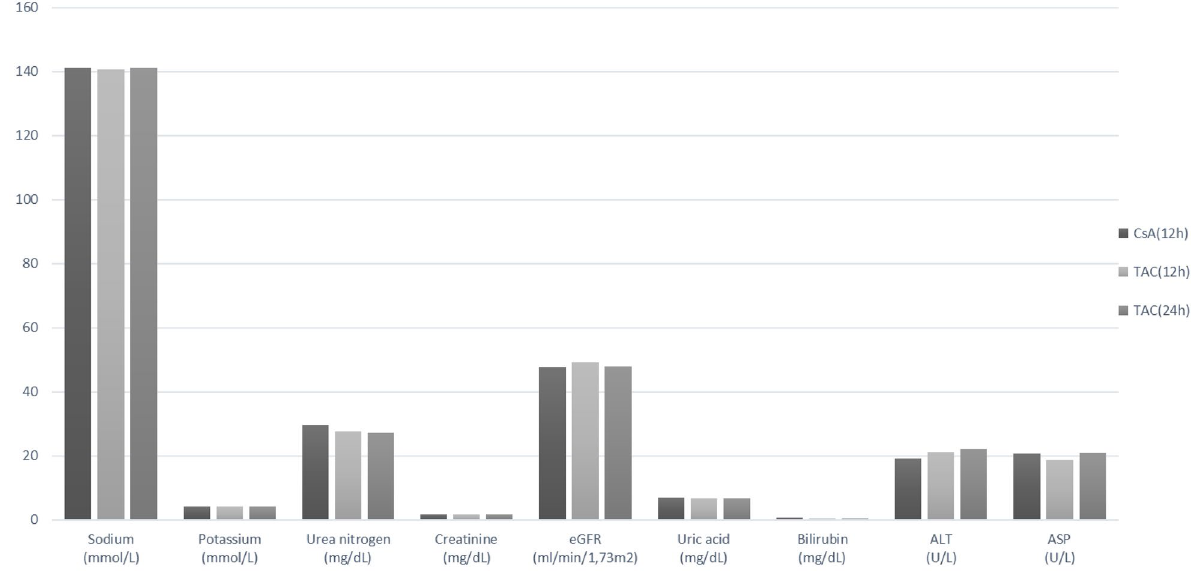
Figure 1. Characteristics of selected clinical and biochemical parameters in renal transplant patients receiving cyclosporine A (CsA) or tacrolimus (TAC) every 12 or 24 h. (CsA-12 h, n = 183), (TAC-12 h, n = 53), (TAC-24 h, n = 156). ALT alanine transaminase, AST aspartate transaminase, eGFR estimated glomerular filtration